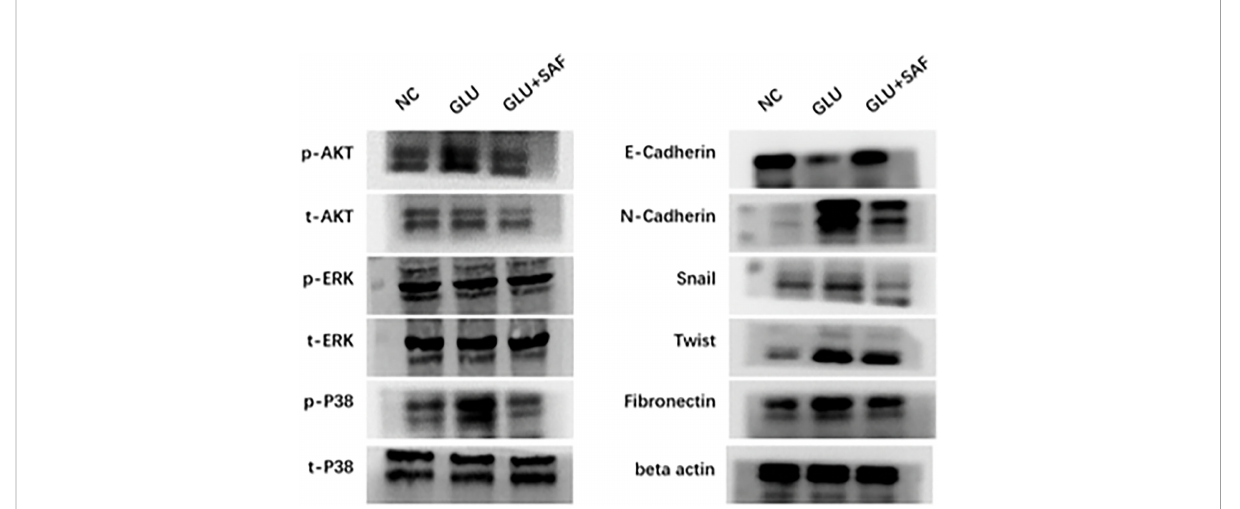
FIGURE 5 Western blot results. Western blot results showing the phosphorylation changes in the p38-AKT signaling pathway. The phosphorylation level of p38 was elevated in the high glucose condition but was inhibited by safranal. However, there was no change in the phosphorylation level of ERK. Under a high glucose condition, the protein expression of factors related to cell migration and adhesion, including N-cadherin, Snail, Twist, and fi bronectin were upregulated in a high glucose condition and could be inhibited by safranal. E-cadherin, on the other hand, demonstrated an opposite expression